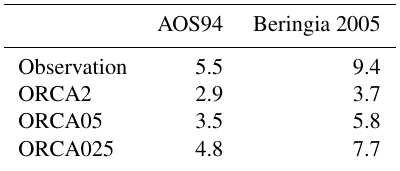
Table 7. Along-section CFC-12 inventories (µmolm − 1 ) integrated over depth and distance along the AOS94 and Beringia 2005 sec- tions vs. colocated results in ORCA2, ORCA05, and